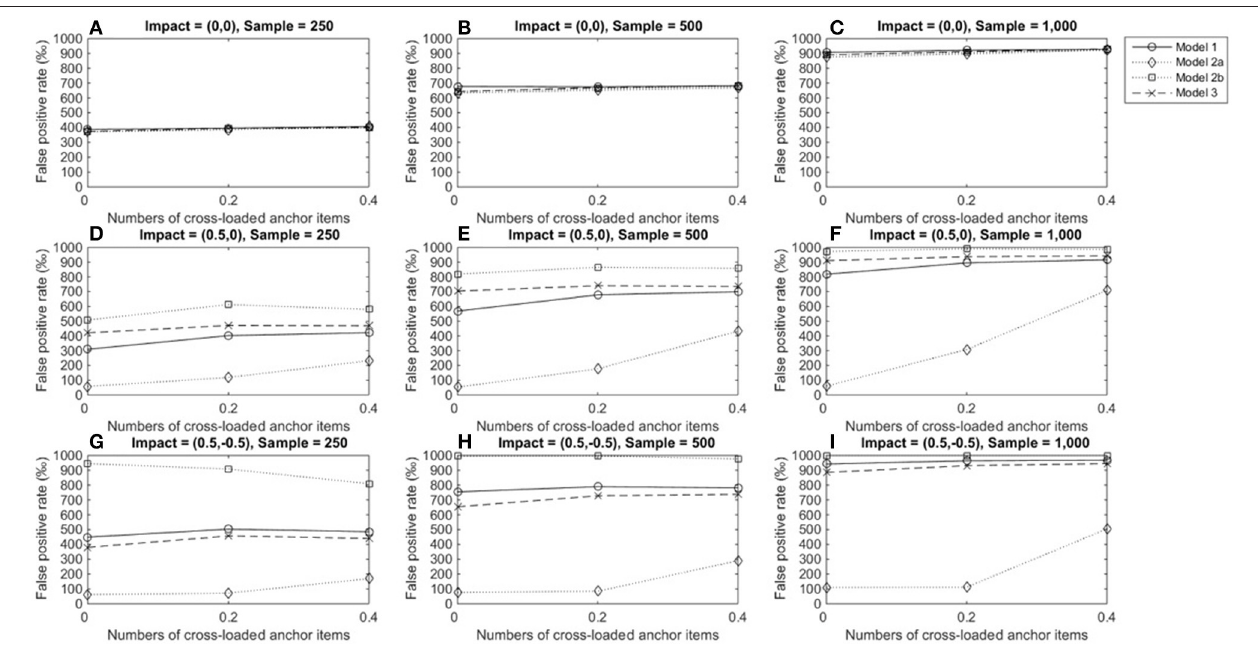
FIGURE 7 | True positive rates when the tested item measured two domains and DIF size was 0.5. For model 1, total scores served as a matching variable; for model 2a, the subtest score of domain 1 was used to match participants; for model 2b, the subset score of domain 2 was used to match participants; model 3 used two subset scores as a matching variable. (A) Impact = (0,0), Sample = 250; (B) Impact = (0,0), Sample = 500; (C) Impact = (0,0), Sample = 1,000; (D) Impact = (0.5,0), Sample = 250; (E) Impact = (0.5,0), Sample = 500; (F) Impact = (0.5,0), Sample = 1,000; (G) Impact = (0.5, − 0.5), Sample = 250; (H) Impact = (0.5, − 0.5), Sample = 500; (I) Impact = (0.5, − 0.5), Sample =